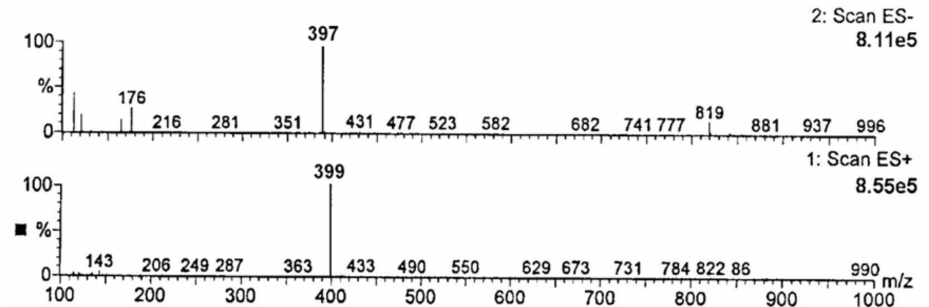
Figure 5. HPLC–MS chromatograms and mass spectra for solid-state RAM in degraded sample (T = 363 K, RH = 76%): identification of